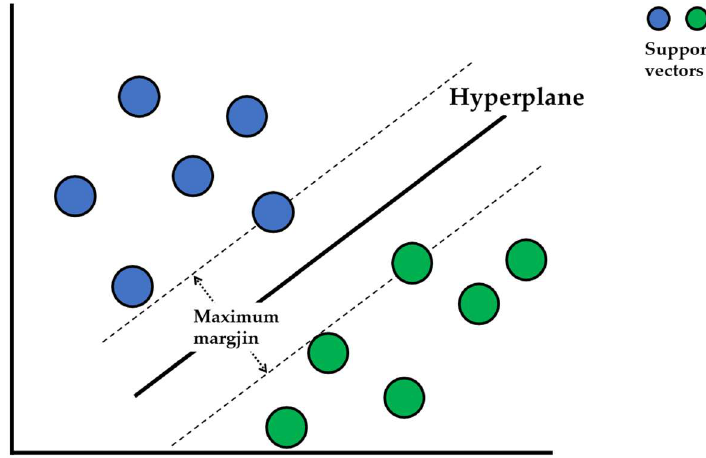
Figure 4. Examples of data and SVM that exist in 2-dimensions.